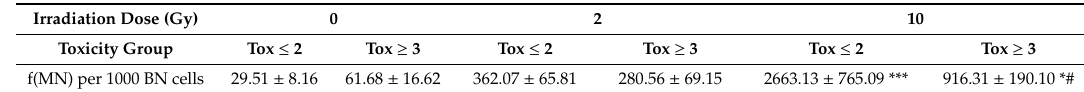
Figure 3. Micronucleus frequency ( a ) and distribution at 10 Gy ( b ) per 1000 binucleated lymphocytes in both groups of patients. Groups Tox ≤ 2 and Tox ≥ 3 correspond to patients presenting grade 2 or less and grade 3 or more of late skin reactions after RT according to RTOG / EORTC, respectively. * for p < 0.05 and *** for p < 0.0001 for irradiated samples compared to non-irradiated ones and # for p < 0.05 for Tox ≥ 3 compared to Tox ≤ 2 group. Table 2. Micronucleus frequency per 1000 binucleated lymphocytes in both groups of patients. Groups Tox ≤ 2 and Tox ≥ 3 correspond to patients presenting grade 2 or less and grade 3 or more of late skin reactions after RT according to RTOG / EORTC, respectively. * for p < 0.05 and *** for p < 0.0001 for irradiated samples compared to non-irradiated ones and # for p < 0.05 for Tox ≥ 3 compared to Tox ≤ 2 group.